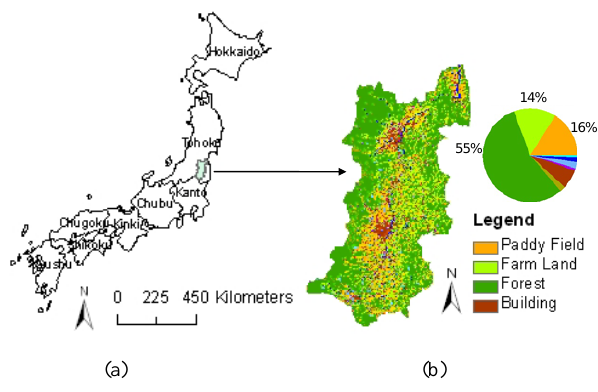
Fig. 5. Abukuma River Basin location in Japan and land use map.